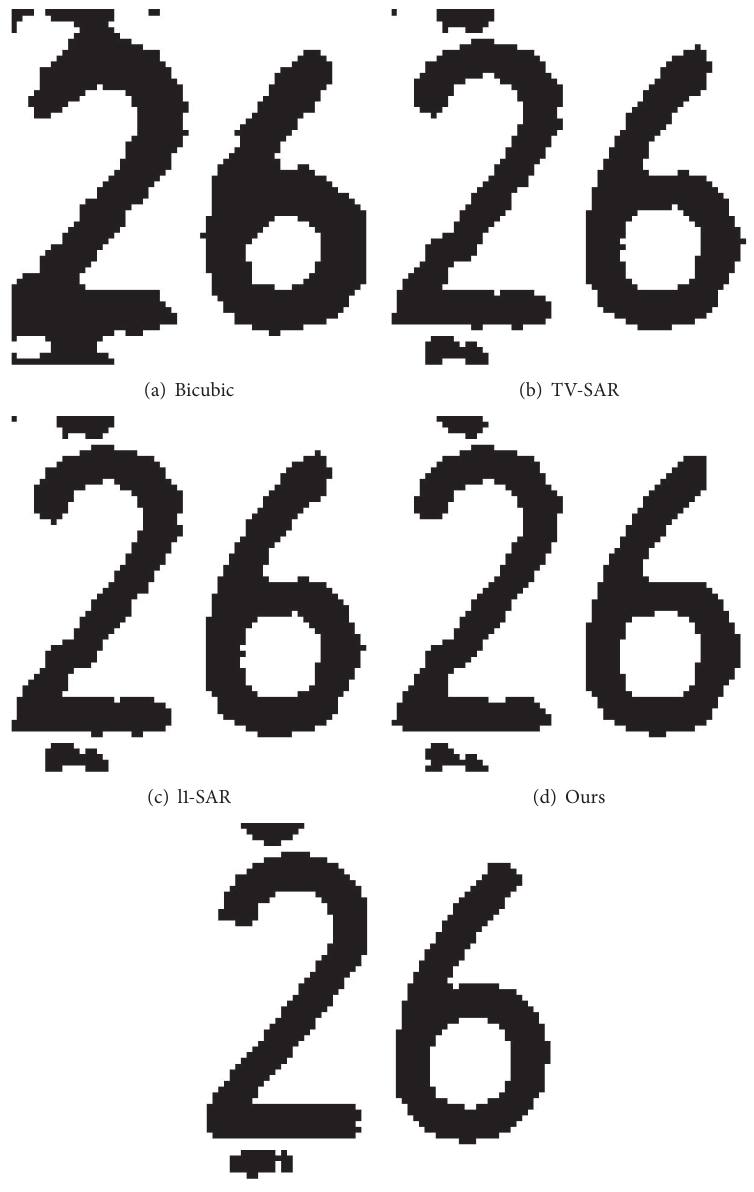
Figure 4: Binary results corresponding to Figure